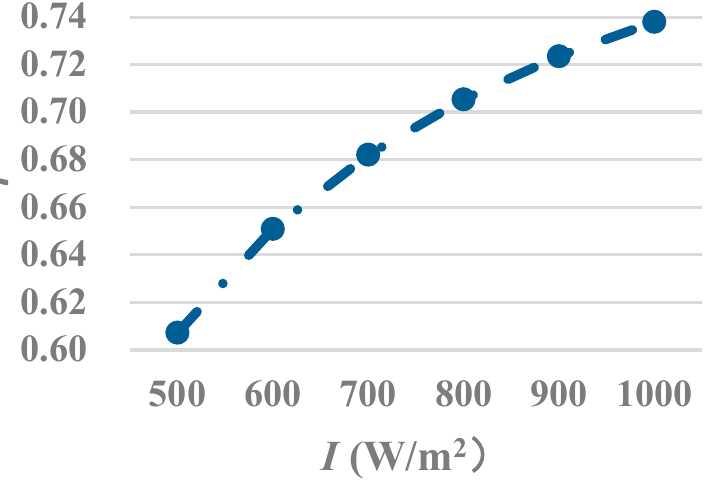
Figure 2. Dependence between efficiency ( η ) and irradiation intensity ( I ) of a typical VTBC solar collector.